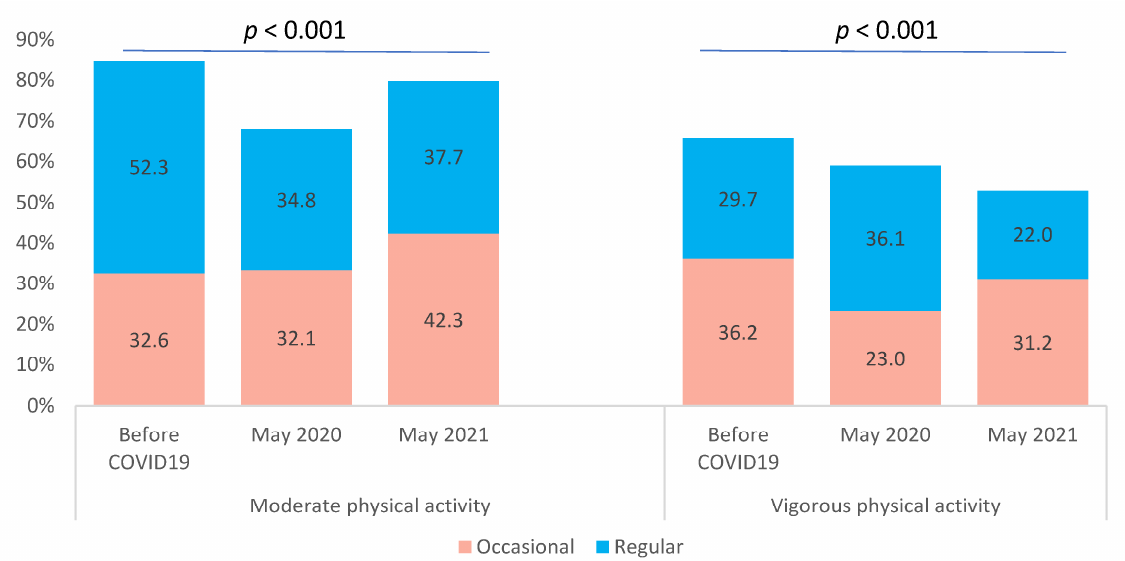
Figure 2. Moderate and vigorous physical activity of university students before COVID-19 pan-